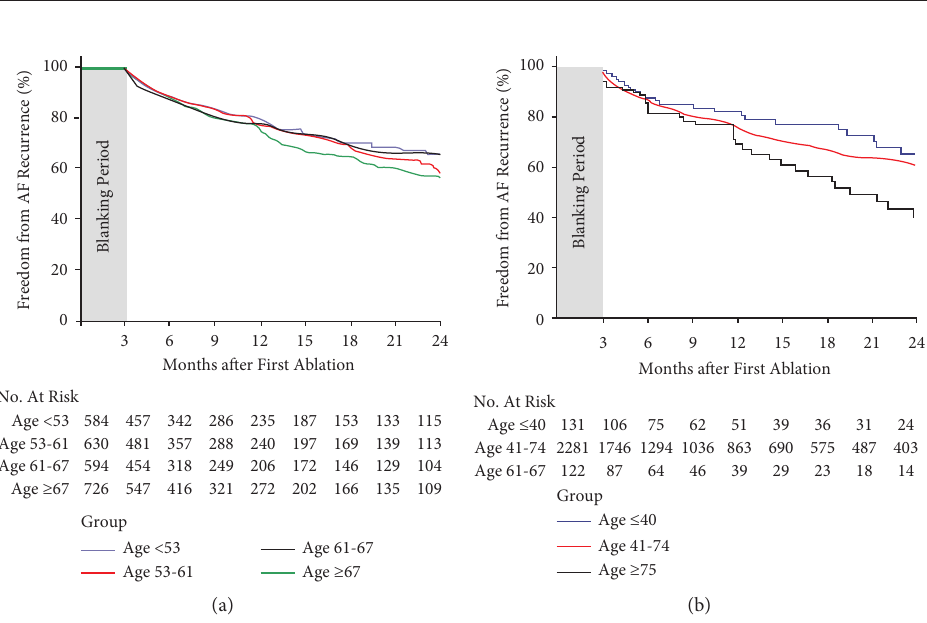
Figure 2: Freedom from AF recurrence in the 1STOP population. (a) Freedom from AF recurrence analyzed in four separate quartiles according to age. Overall adjusted p value from Log-Rank Test � 1.000. The mean follow-up duration was 15.3 ± 14.7 in the whole population with no significant difference among the groups (16.1 ± 14.9, 15.6 ± 15.2, 14.9 ± 15.0, 14.8 ± 13.9 in the four groups from the youngest to the oldest). (b) Freedom from AF recurrence analyzed in three groups according to age (age ≤ 40, 41 < age < 74, age ≥ 75). Overall adjusted p value from Log-Rank Test � 0.113. The mean follow-up duration in the three age’s group was 16.2 ± 15.3, 15.3 ± 14.7, and 13.7 ± 14.5 in the age ≤ 40, 41 < age < 74, and age ≥ 75 groups, respectively ( p � 1 .